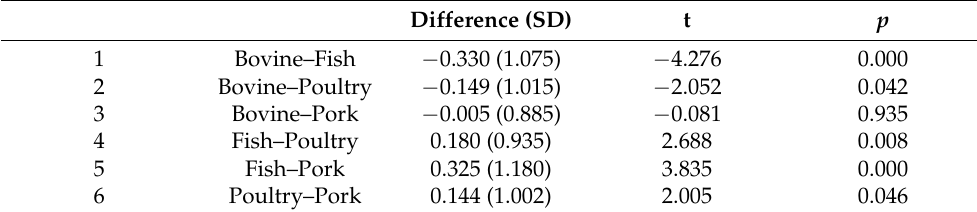
Table 6. Pairwise comparisons of intentions to eat animals fed with insects ( n = 194).